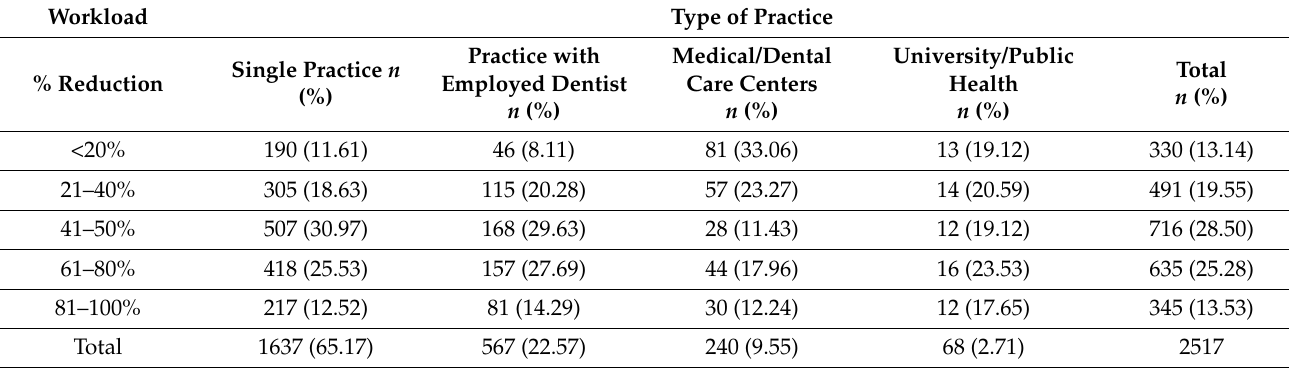
Table 4. Weekly workload reduction during the lockdown period by the type practice where the responders declared to